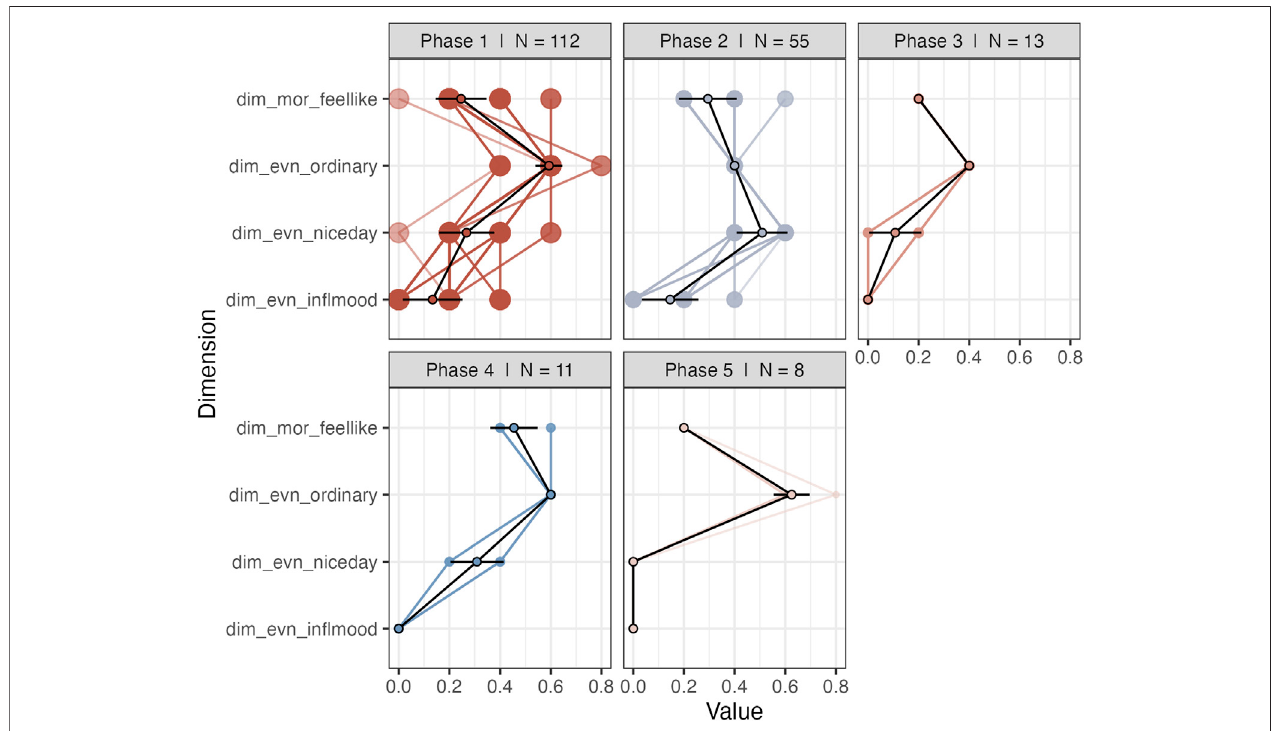
FIGURE 12 | Pro fi les of recurring phases of the Day subsystem.